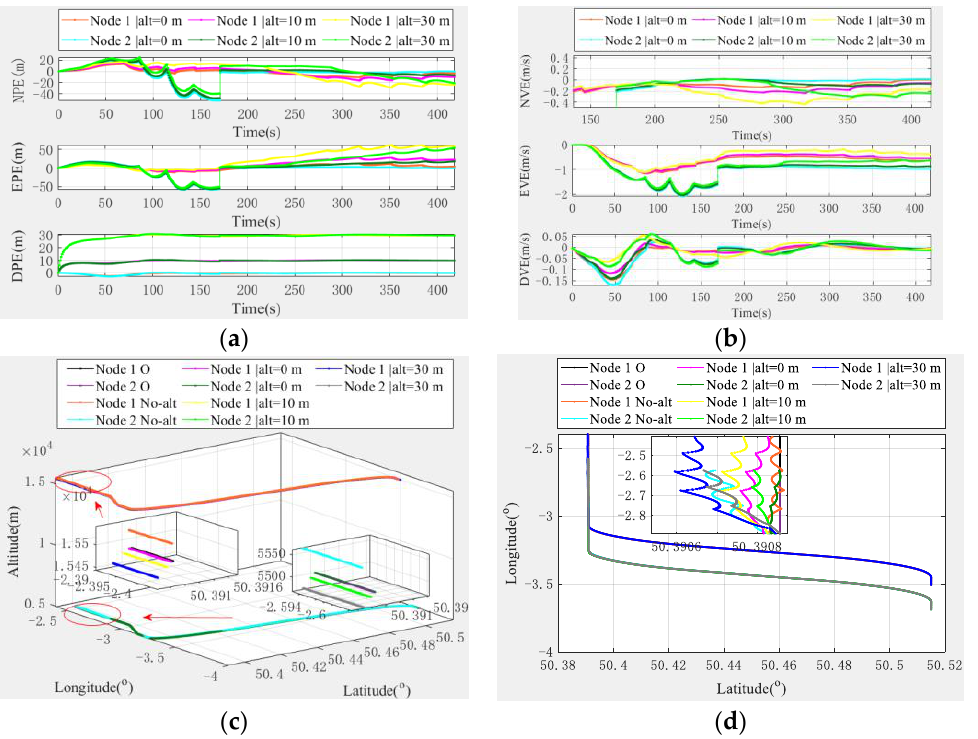
Figure 6. Altimeter-assisted joint navigation positioning error curve. ( a ) Position error curve, ( b ) velocity error curve, ( c ) 3D trajectory error curve, and ( d ) 3D projection error curve.